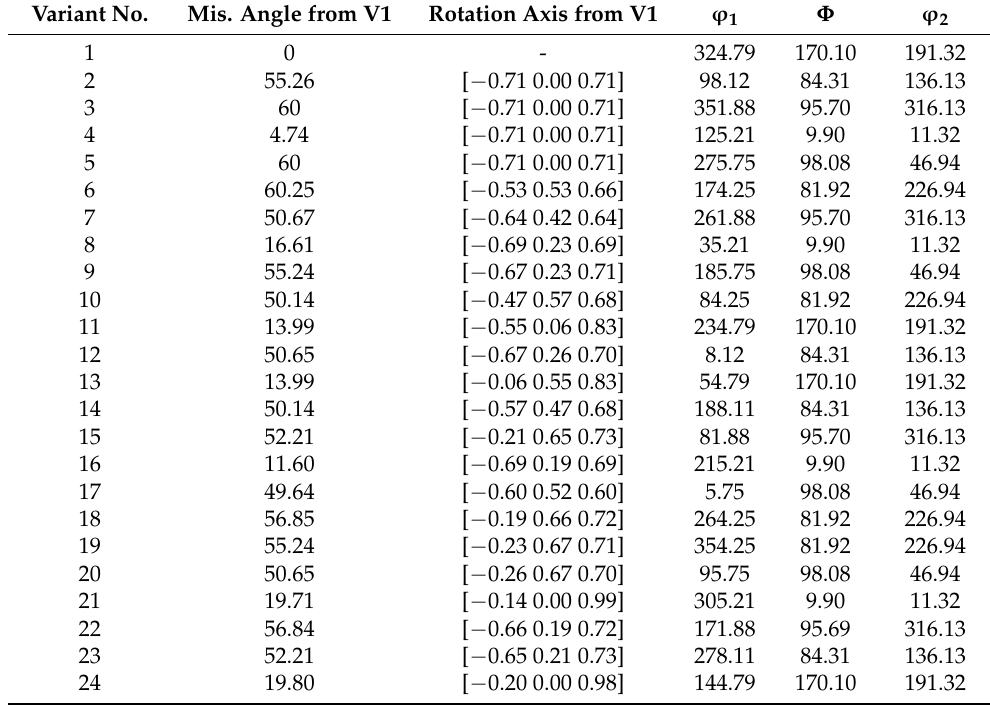
Table 2. Calculated variants from the GT OR.